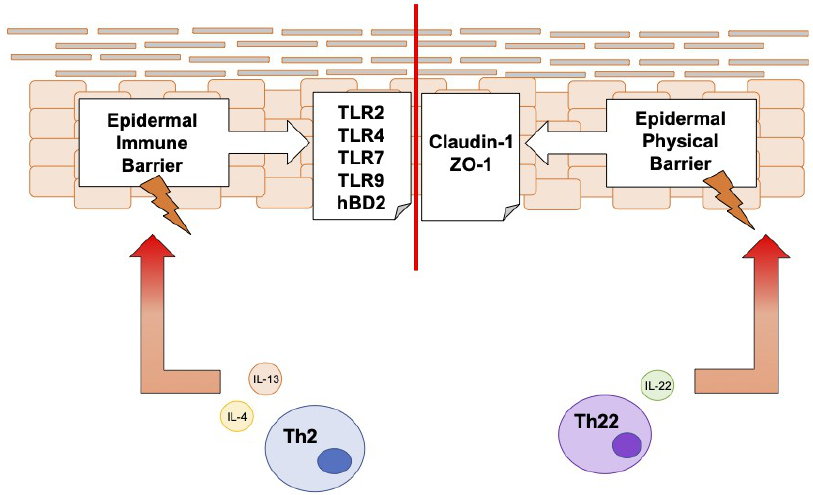
Figure 11. Schematic representation of the early impairment of the epidermal barrier in a proin- flammatory microenvironment mimicking atopic dermatitis. TLR: Toll-like receptor; hBD-2: human beta-defensin 2; IL-4: interleukin 4; IL-13: interleukin 13; Th2: T helper (Th) 2 cells; ZO-1: zonula occludens 1; IL-22: interleukin 22; Th22: T helper (Th) 22